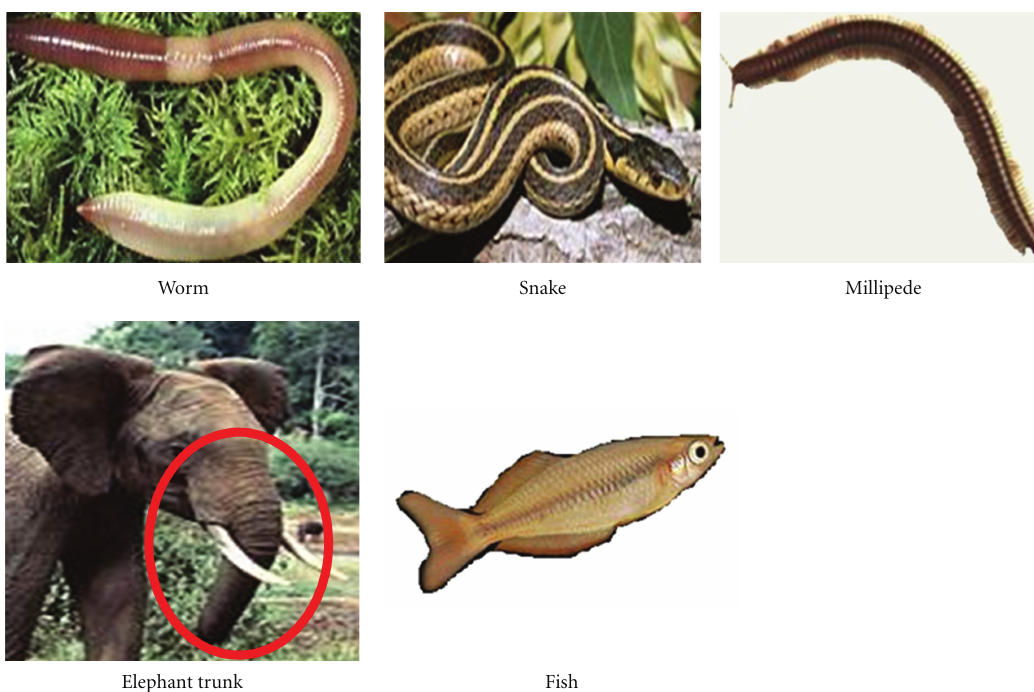
Figure 1: Examples of biological hyper-redundant bodies. Source